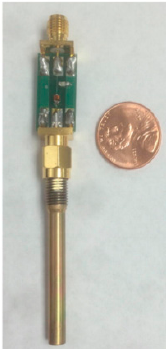
Figure 13. Picture of EIMN with an ultrasonic transducer showing the printed circuit board (PCB) implemented with shunt capacitor of 100 pF and series inductor of 8 nH. Reproduced with permission from Reference [41], Copyright Elsevier, 2016.